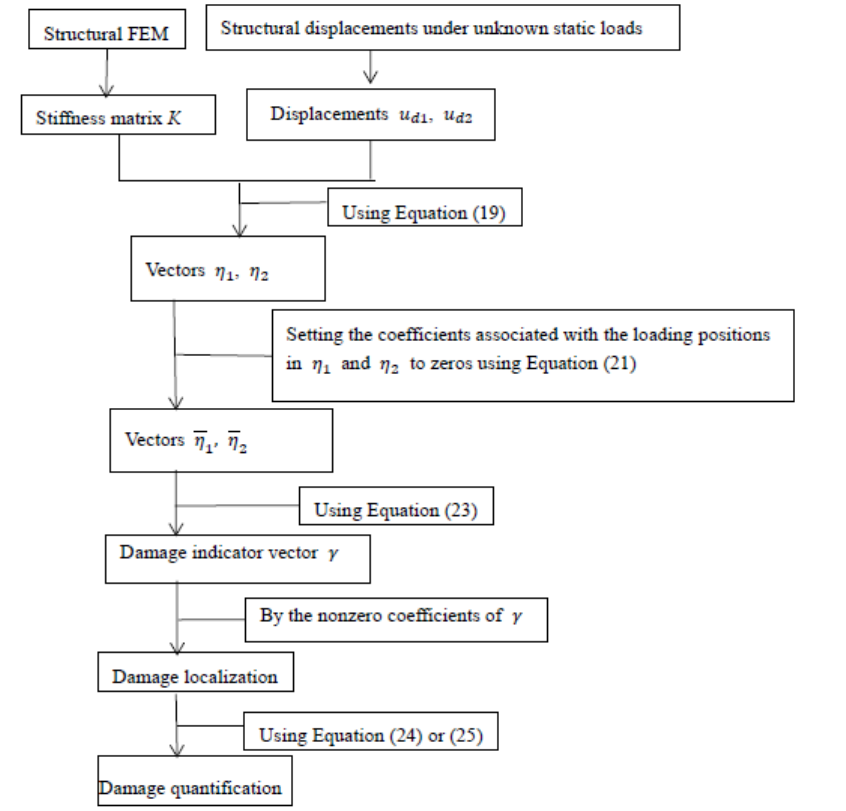
Figure 1. The flowchart of the whole technique.